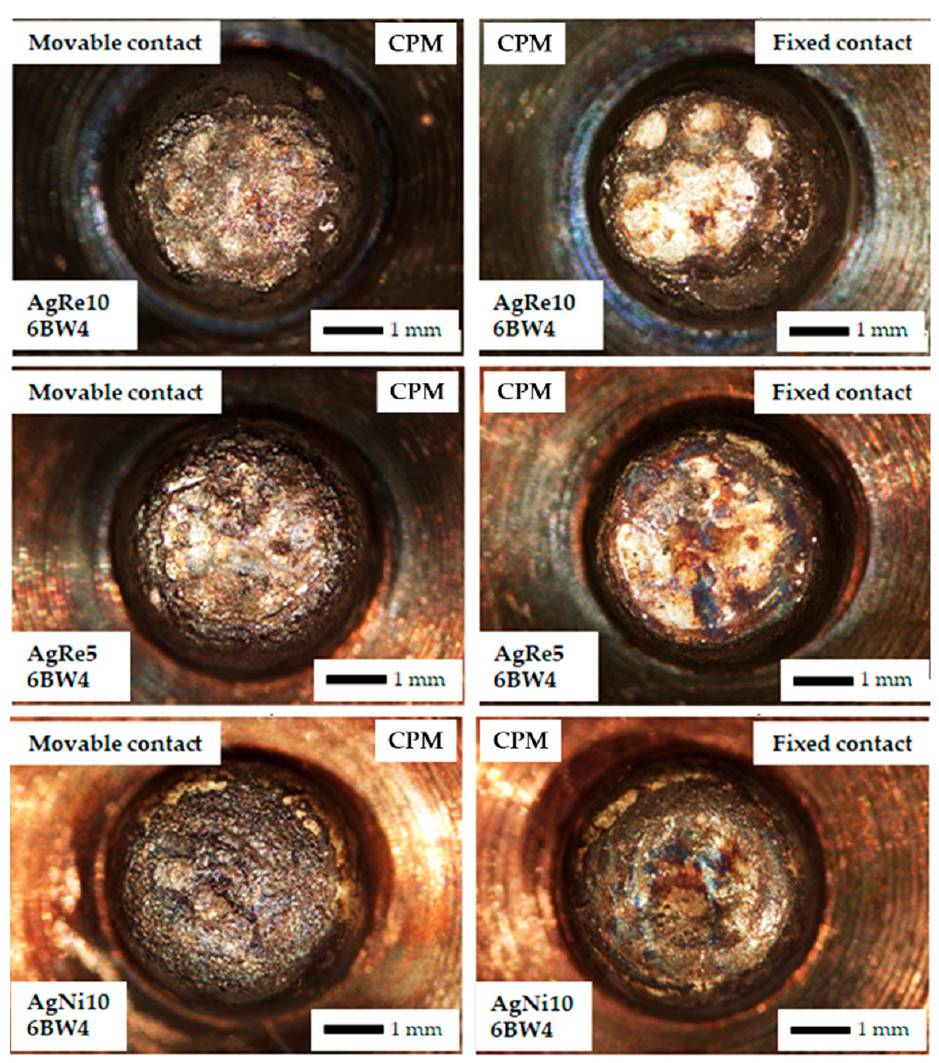
Figure 6. Macro photographs of contact surface after the arc erosion testing DC current = 10 A, voltage = 550 V, CPM = classical powder metallurgy.